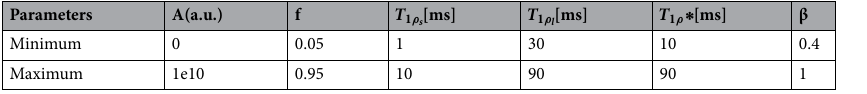
. The exponential signals are sampled at K different TSLs defined by the sampling schedule t and we can thus represent it by s ( t , θ ) = [ s ( t 1 , θ ) , s ( t 2 , θ ) , ..., s ( t K , θ ) ] T . This expression Curve fitting algorithm. The curve fitting for both models is done using the Nonlinear Least Squares (NLS) described by